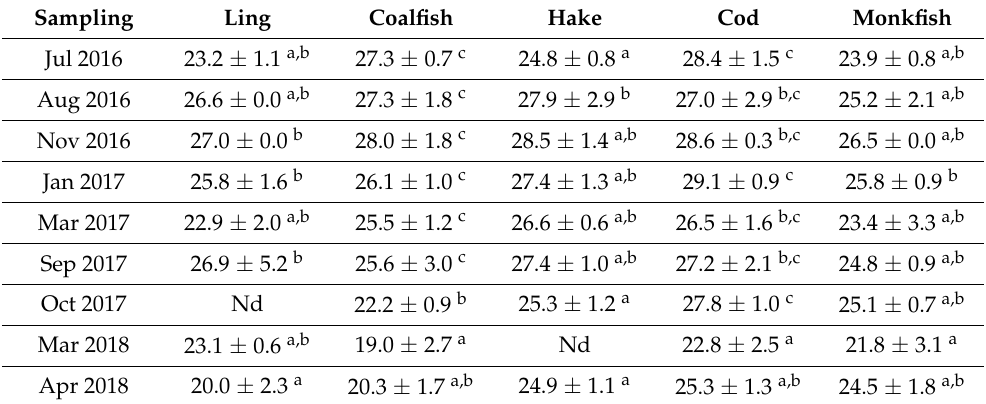
Table 5. Sum of omega-3 PUFA (%) in fish livers sampled at different time points. Sampling Ling Coalfish Hake Cod